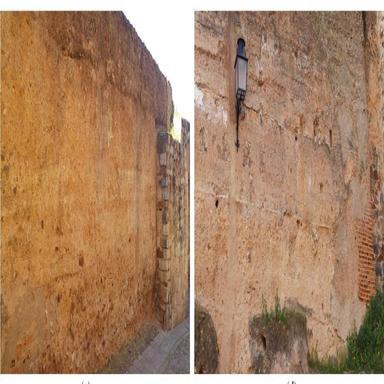
Detail of the walls where were extracted samples MC-14 (a), MC-13 (b), MC-11 (c), MC-16 (d) and MC-2 (e).